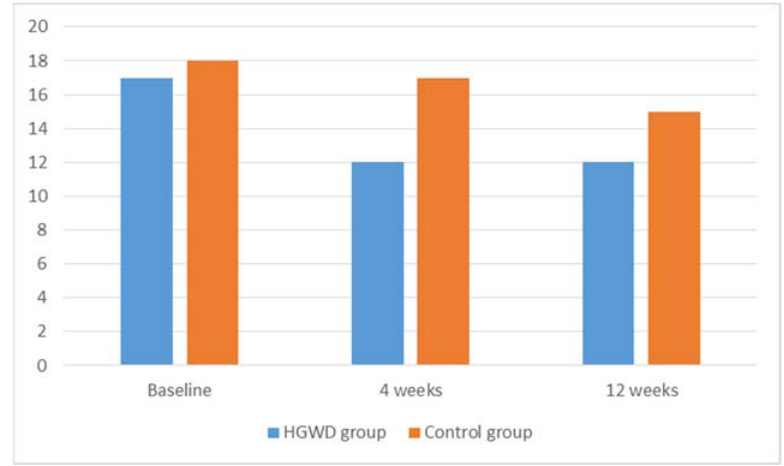
Figure 2. Median EORTC QLQ-CIPN20 sensory scores of HGWD group and control group. Abbreviation: EORTC QLQ-CIPN20: theEuropeanOrganizationfor theResearchand Treatmentof Cancer-Chemotherapy-induced peripheral neuropathy 20; HGWD: Huangqi Guizhi Wuwu decoction. Table 3. Adverse events related to